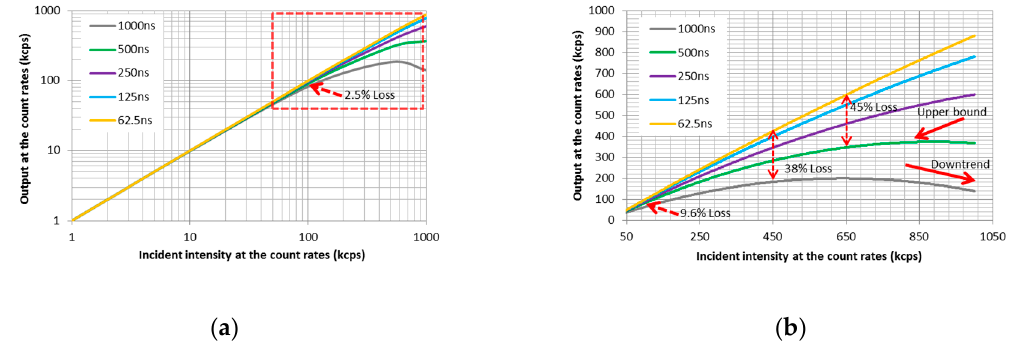
Figure 14. The corresponding curves of the counting rate at the output end with the changing incident intensity. The system counting error is not apparent when the incident intensity is below 50 kcps, regardless of whether the pulse shaper’s peaking time is 62.5 ns or 1000 ns. Nevertheless, the counting error gradually appears with increasing incident photon rates, as shown in the red dotted box in ( a ). More details of the curves in this area are shown in ( b ).